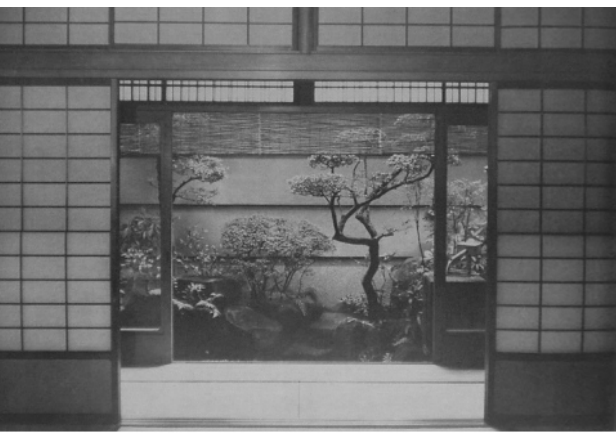
Figure 15 Live Picture Wall. The Japanese House. A tradition for Contemporary Architecture, 1964. Heinrich Engel